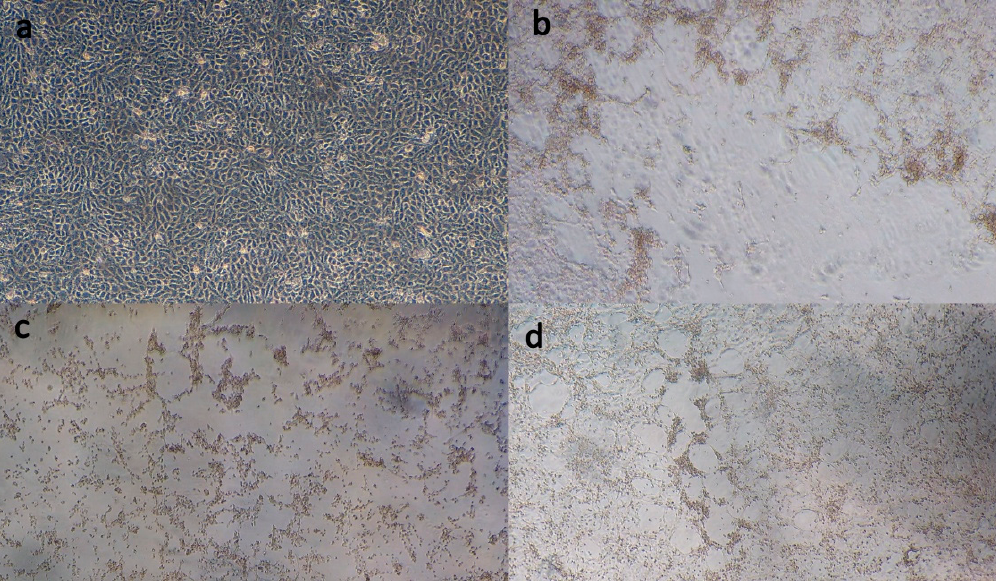
Figure 1. Photos of MDBK cells: ( a ) Cell control; ( b ) and ( c ) MDBK cells displaying cytopathic effects (CPE) and syncytia formation 72 h post-infection with isolates 43TR2018 and 34TR2018, respectively; ( d ) MDBK cells displaying limited CPE and syncytia foci 72 h post-infection with isolate 07TR2019.